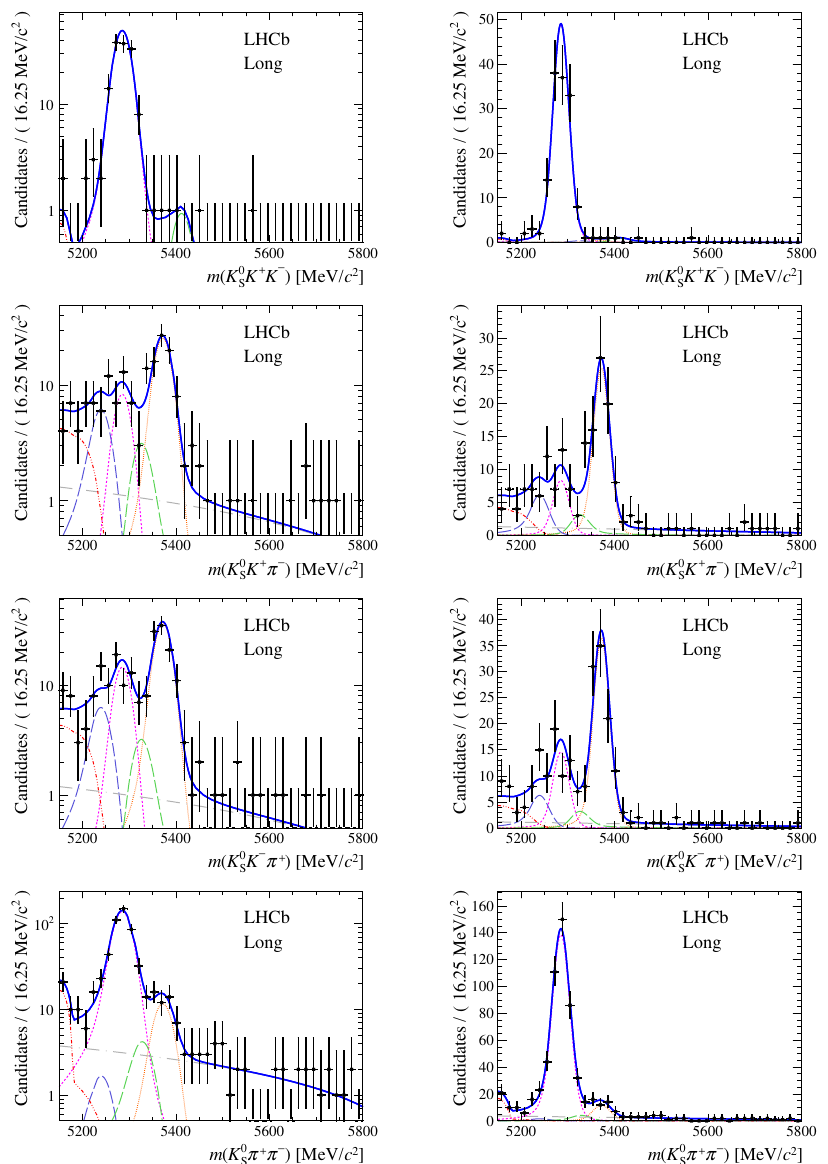
Figure 14 . Results of the simultaneous (cid:12)t to data (long, 2012b) with the BDT optimisation corresponding to the suppressed modes. The modes K 0 are shown from top to bottom. The left-hand side plots show the results with a logarithmic scale and the right-hand side with a linear scale. Legend is similar to that of plots shown in (cid:12)gure 1.